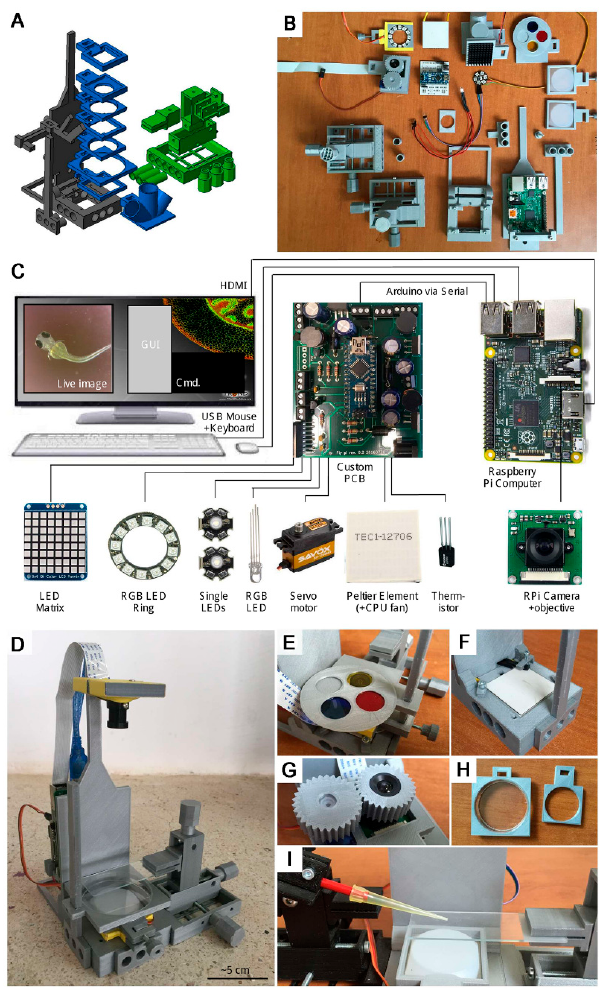
Figure 5. The “FlyPi”/“100€ Lab” platform. Notice the Raspberry Pi and Arduino (on top of custom made PCB) in ( B ) and ( C ). ( A ) The 3D model, colour coded by core structure (black), mounting adapters (blue), and micromanipulator (green). ( B ) Printed parts and electronics, partially assembled. ( C ) Wiring diagram and summary of electronics. ( D ) The assembled FlyPi with single micromanipulator and light-emitting diode (LED)-ring module, diffusor, and Petri dish adapter mounted in the bottom. ( E ) Filter wheel mounted above the inverted camera objective. ( F ) Peltier element and thermistor embedded into the base. ( G ) Automatic focus drive. ( H ) Petri dish mounting adapters. ( I ) A second micromanipulator mounted to the left face of FlyPi holding a probe (here, a 200- µ L pipette tip for illustration) above the microscope slide mounted by the micromanipulator on the right. Reproduced with permission from